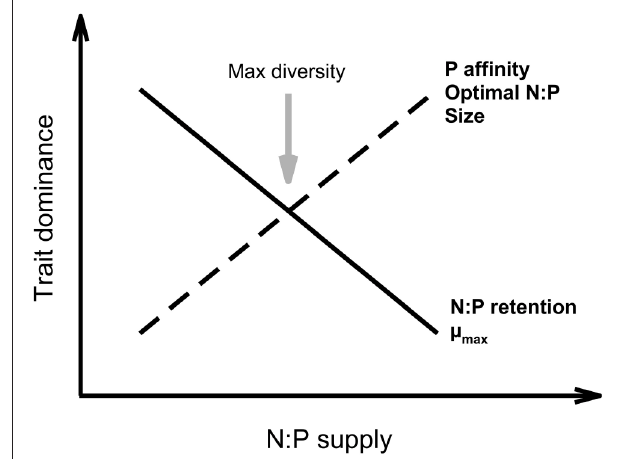
FIGURE 2 | Influence of N:P supply on trait dominance. With increasing N:P supply, an organism’s optimal N:P ratio, P uptake affinity, and size are expected to increase, and organisms that selectively retain P over N should have higher maximal growth rates than those which do not, as predicted by the Growth Rate Hypothesis (Sterner, 1995b; Elser et al., 2000c). Further, Tilman’s resource-ratio based theory of competition predicts that biodiversity should be maximal (gray arrow) at balanced supply ratios (Tilman,